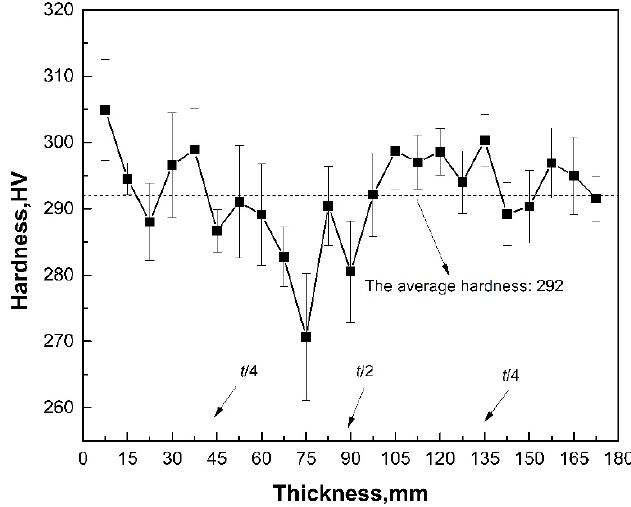
Figure 6. Hardness variations in the thickness direction of the experimental steel.